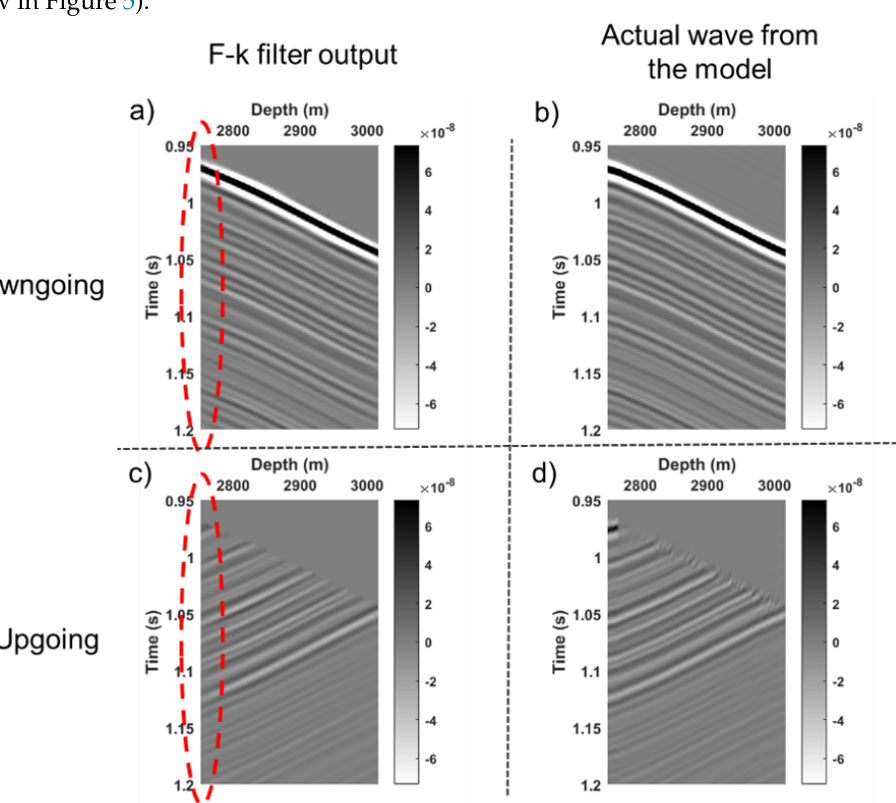
Figure 10. F - k filter outputs compared with the up- and downgoing wave generated by the model. ( a , b ) show the downgoing wave from the f - k filter and the model. ( c , d ) show the upgoing wave from the f - k filter and the model.